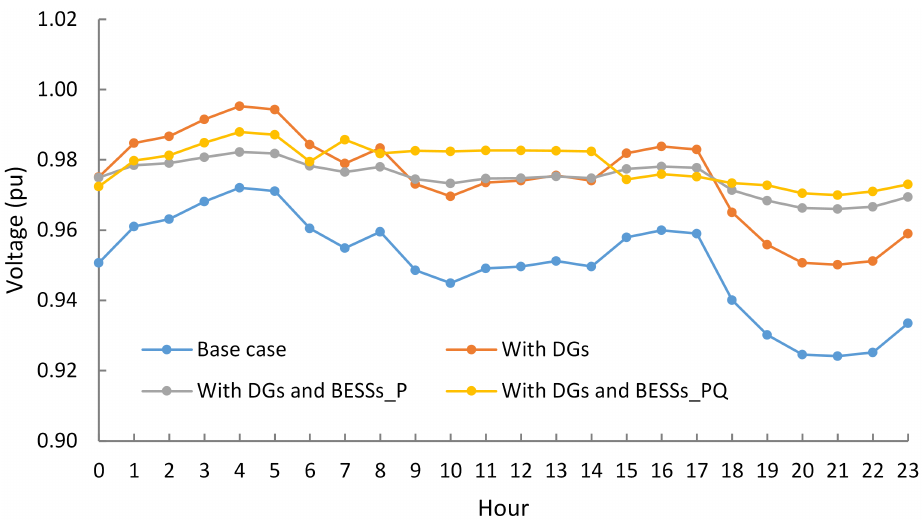
Figure 13. 141-bus system voltages performance during the